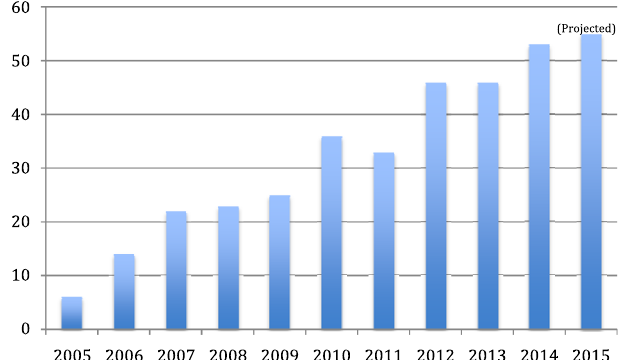
FIG. 1. Number of articles published per year in Physical Review Special Topics – Physics Education Research